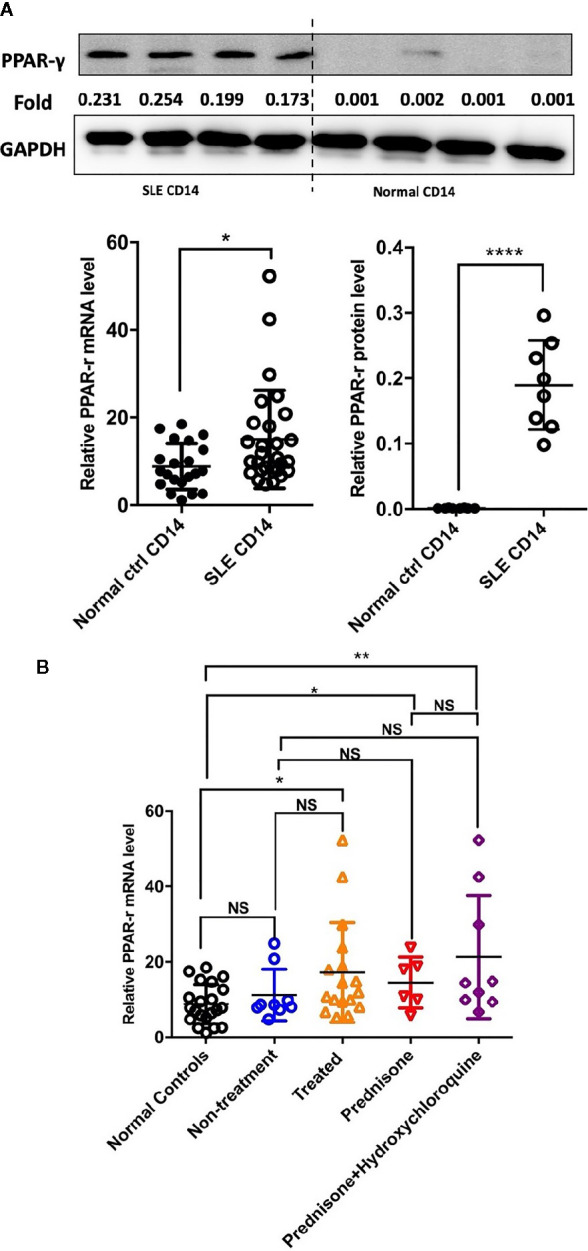
PPAR-γ expression is increased in the CD14+ monocytes from SLE patients. (A) Both the mRNA level (n1 = 21, n2 = 28) and the protein level (n1, n2 = 8) of PPAR-γ were significantly higher in the circulating CD14+ monocytes derived from SLE patients than healthy controls. One representative blot is shown. (B) The mRNA expression level of PPAR-γ was significantly increased in the CD14+ monocytes from the treated SLE patients (n = 17) compared with those from the normal controls (n = 21), and glucocorticoid (n = 6) or combined with hydroxychloroquine (n = 9) could elevate the expression of PPAR-γ in the SLE patients. RT-PCR results were normalized to GAPDH. Each symbol represents an individual healthy control or patient (n1 represents healthy controls, n2 represents SLE patients. *P < 0.05, **P < 0.01, ****P < 0.0001).